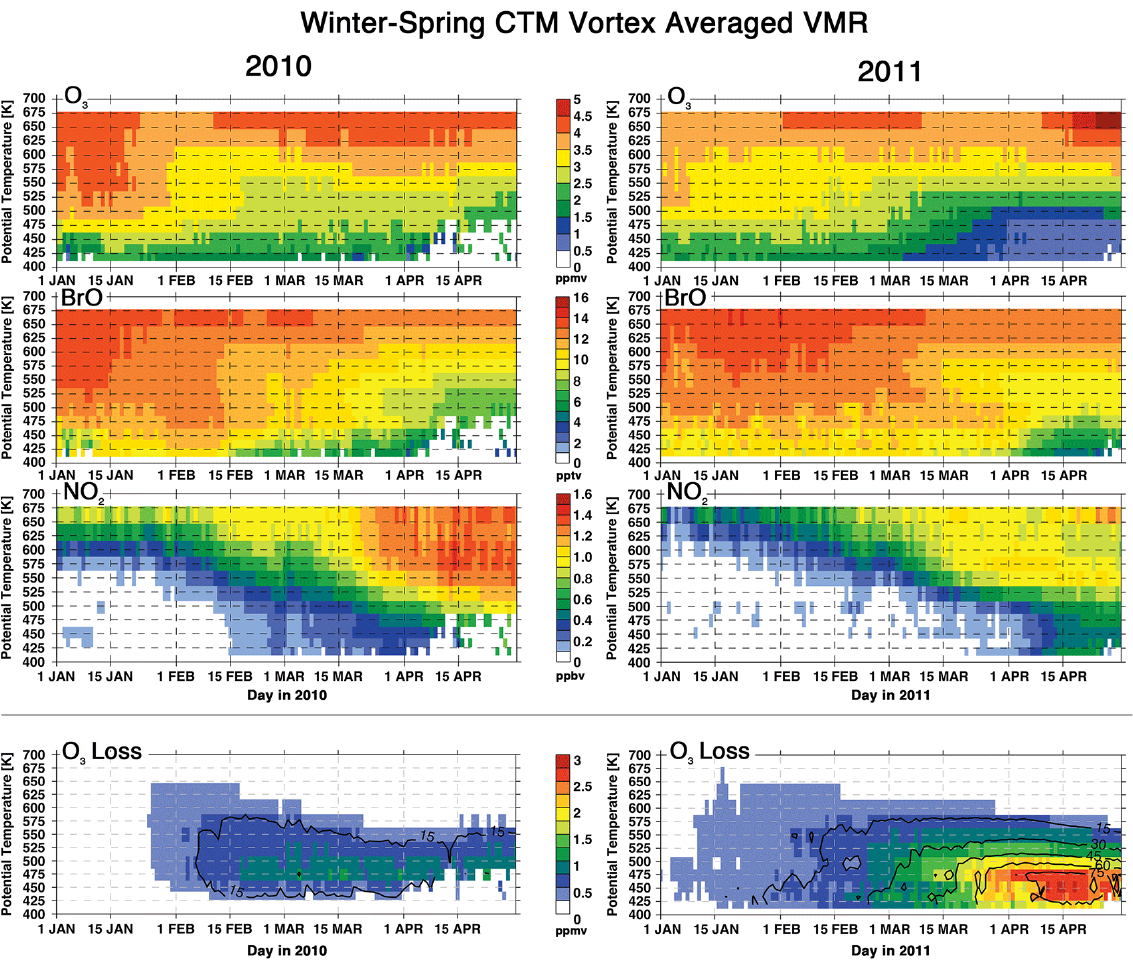
Fig. 8. As in Fig. 5, except for the respective CTM simulations. Here, relative ozone losses are interpreted relative to the volume mixing ratio of a quasi-passive ozone tracer which is only affected by large-scale photochemistry, not considering heterogeneous